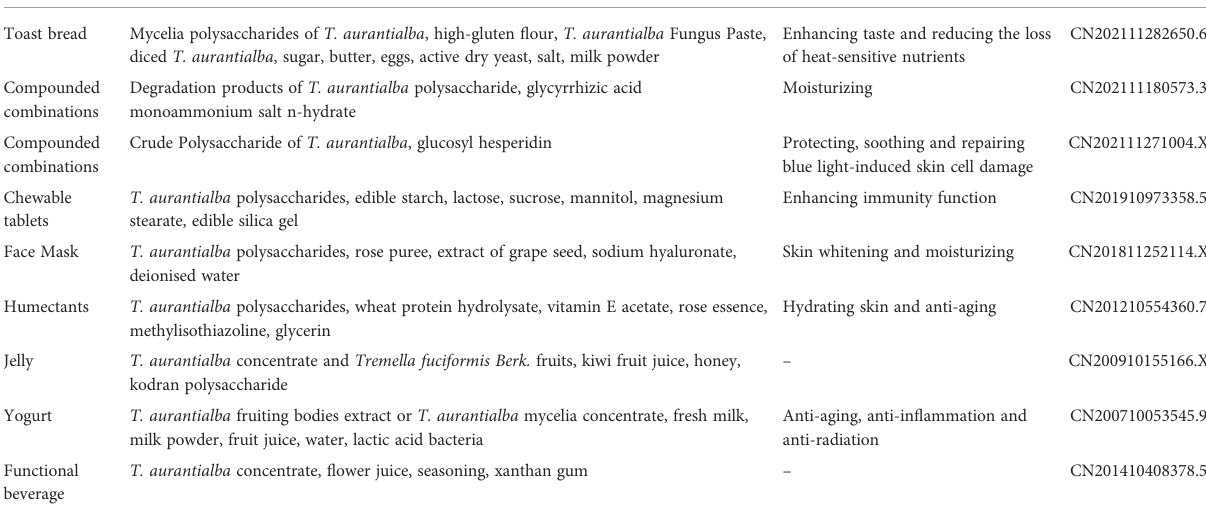
TABLE 3 Application of T. aurantialba